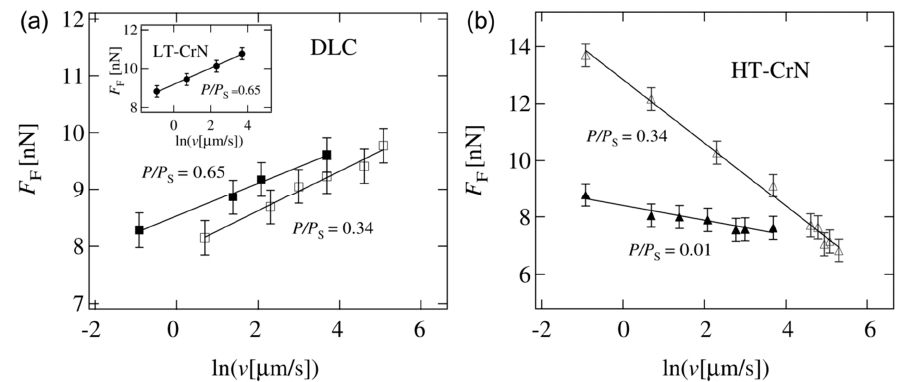
Figure 21. ( a ) Friction force as a function of sliding velocity on partially hydrophobic diamond-like carbon (DLC) surfaces at P / P S = 0.34 and 0.65 ( P is the vapor pressure and P S is the saturated vapor pressure). Inset: LT-CrN films at P / P S = 0.65. ( b ) Friction force as a function of sliding velocity on hydrophilic surface (HT-CrN) at P / P S = 0.01 and 0.34. Reprinted from Ref. [134], Copyright 2002, with permission from APS publications.